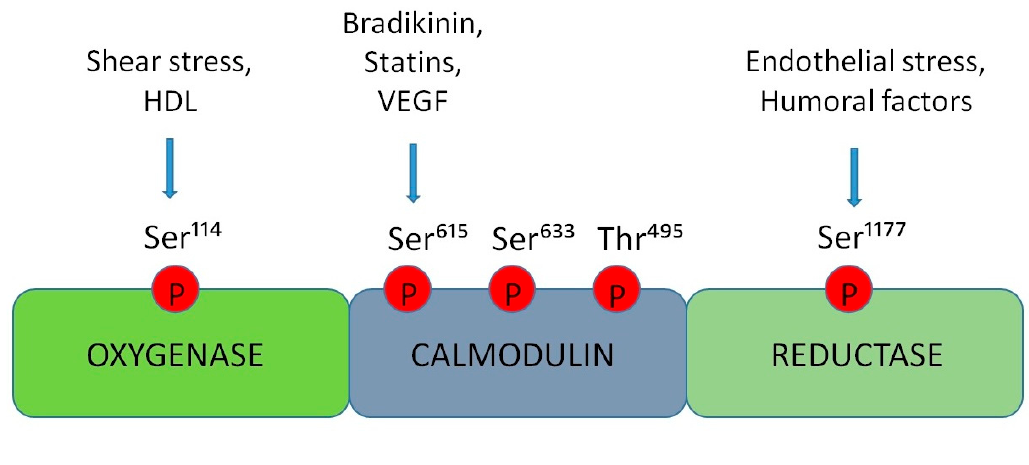
Figure 1. Nitric oxide synthase (NOS) regulation. Schematic representation of the phosphorylation sites on the endothelial isoform (eNOS) enzyme and of the mechanical and humoral factors involved. Shear stress and HDL increase the phosphorylation on eNOS-Ser 114 site; the eNOS agonistic VEGF, statins, and bradykinin increase the phosphorylation of eNOS-Ser 615 . Moreover, the phosphorylation of eNOS-Ser 1177 and eNOS-Ser 633 leads to an increase of eNOS activity, on the other hand the phosphorylation of eNOS-Thr 495 leads to a reduction of the activity of this